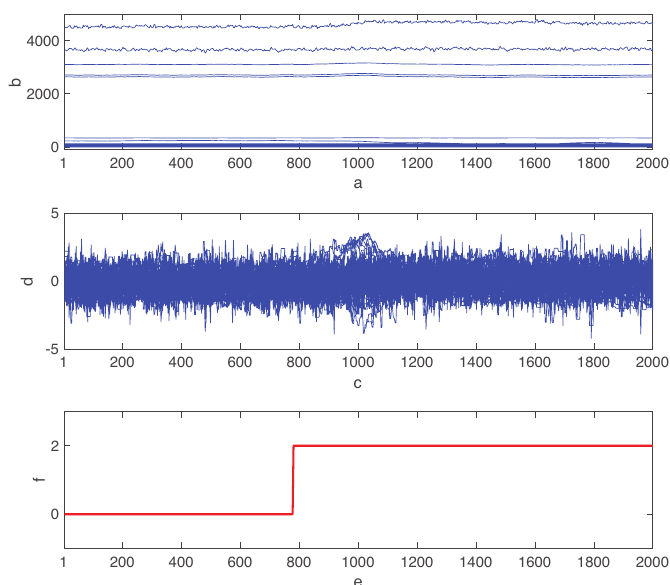
Figure 4. Process state measurements when fault 02 occurs at 780